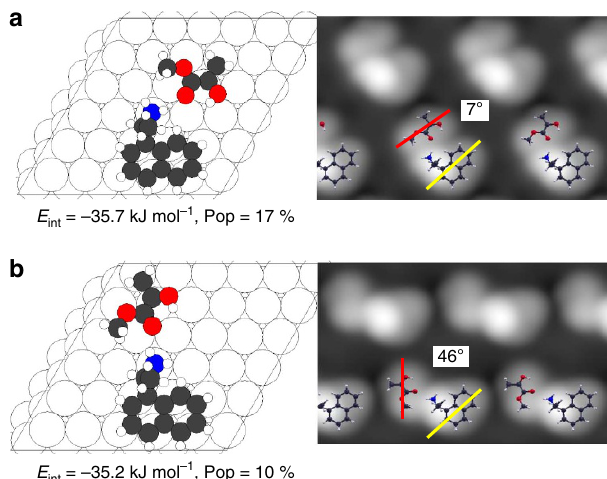
Figure 6 | Calculated structures of the docking complexes that form between endo-NEA and MP on Pd(111). Depictions of DFT-optimized structures of the most stable docking complexes formed between MP and endo-NEA adsorbed on the dibridge[6] site, indicated as a and b . The interaction energies calculated including van der Waals’ interactions are shown below each structure. The STM images simulated by the Tersoff– Hamman method are shown adjacent to each structure. The angles between the axis in the simulated images of the enol tautomer of MP, indicated by red lines, and the long axis of the naphthyl group of NEA, indicated by yellow lines, are also indicated. The relative population of each type of docking complex is calculated using a Boltzmann distribution and is reported below the respective